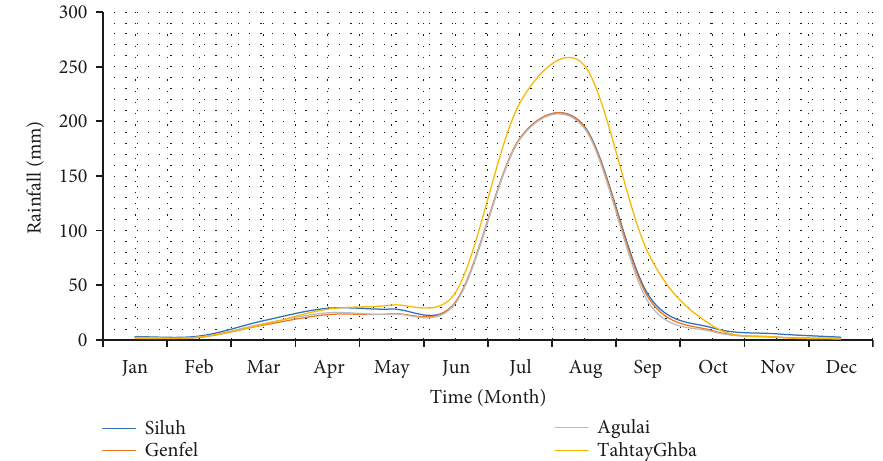
Figure 2: The mean monthly rainfall (mm) at Siluh, Genfel, Agulai, and Tahtay Ghba catchments.